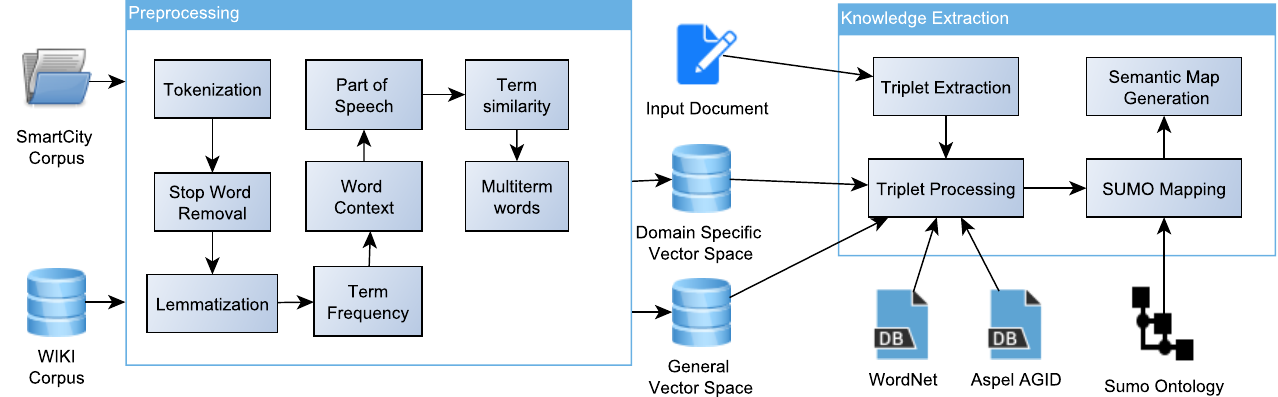
Figure 1. Flow of Knowledge Extraction from Text. Before we can extract the knowledge from the text, we need to generate some domain-specific text statistics. These statistics are used the generation of triplets and of the knowledge